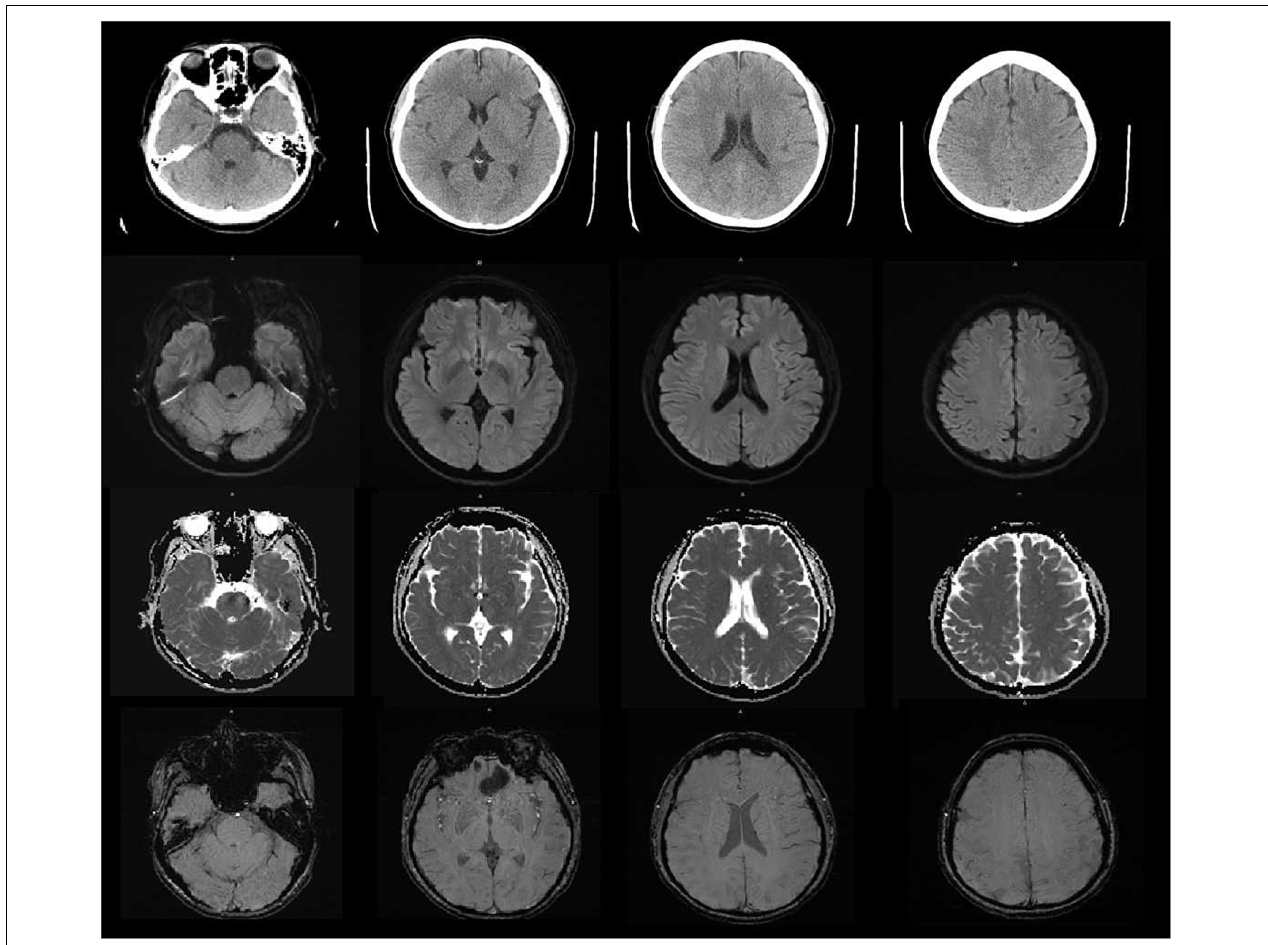
FIGURE 2 | The cranial MRI showed no abnormal signal was found in T1-weighted imaging,T1WI (TI), T2-weighted imaging,T2WI (T2), diffusion-weighted imaging (DWI) and susceptibility weighted imaging (SWI).